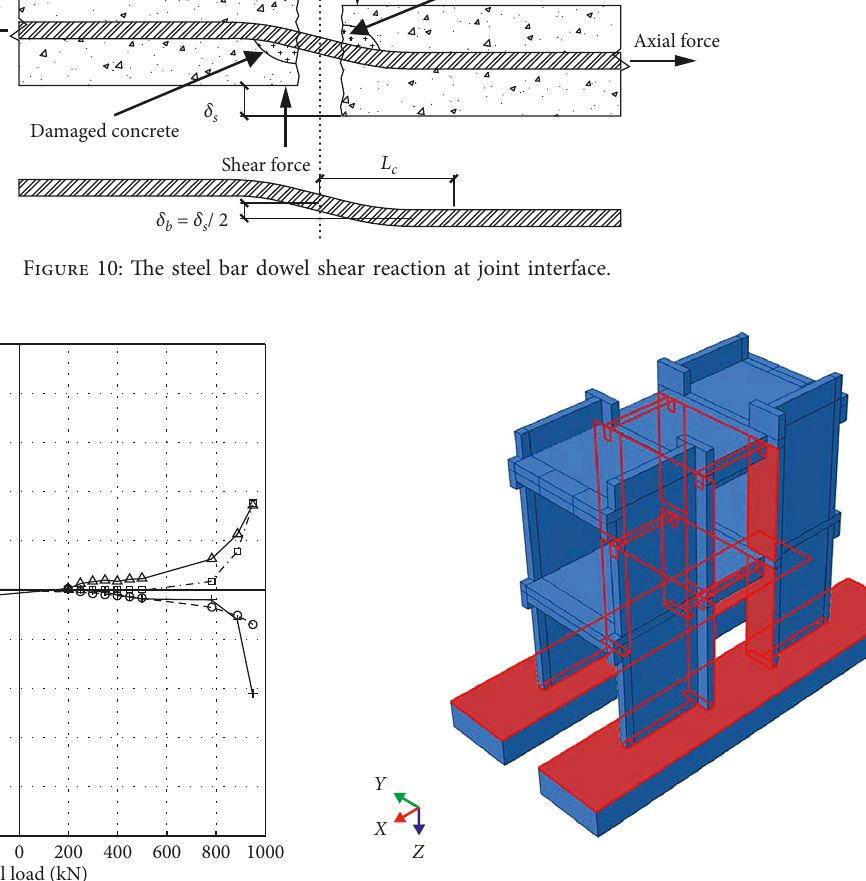
Figure 12: The concrete contact surfaces of NPGCS finite-element spatial